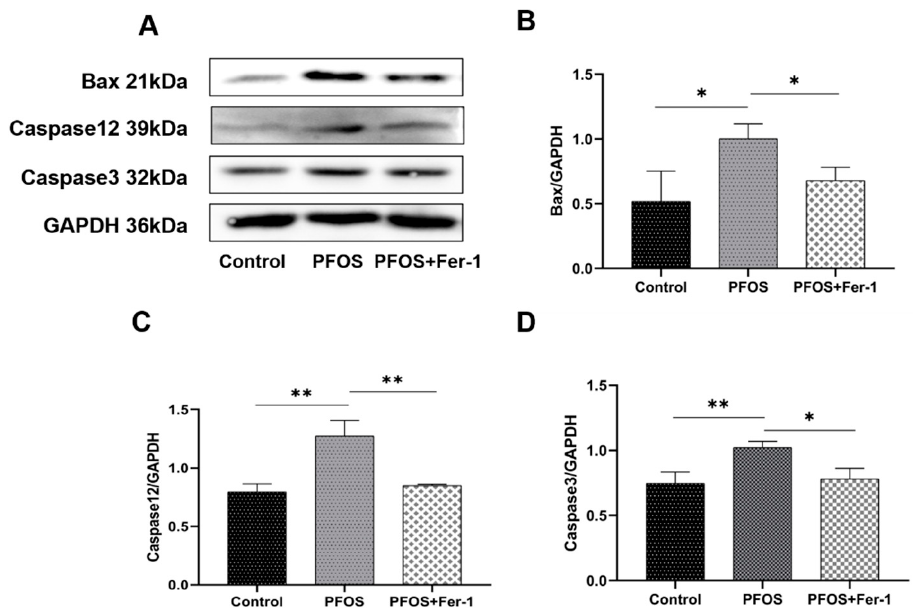
Figure 10. Expression of Bax, Caspase12 and Caspase3 in HK-2 cells exposed to PFOS or/and Fer-1. HK-2 cells were exposed to PFOS at 200 µ M for 12 h or/and cultured with Fer-1 at 1 µ M for 2 h prior to exposure to PFOS; the results were from three independent experiments. Data were expressed as mean ± SD (n = 3), * p < 0.05, ** p < 0.01. ( A ) Western blot of Bax, Caspase12 and Caspase3; ( B ) comparison of Bax expression among control, PFOS and PFOS+Fer-1 group cells; ( C ) comparison of Caspase12 expression among control, PFOS and PFOS+Fer-1 group cells; ( D ) comparison of